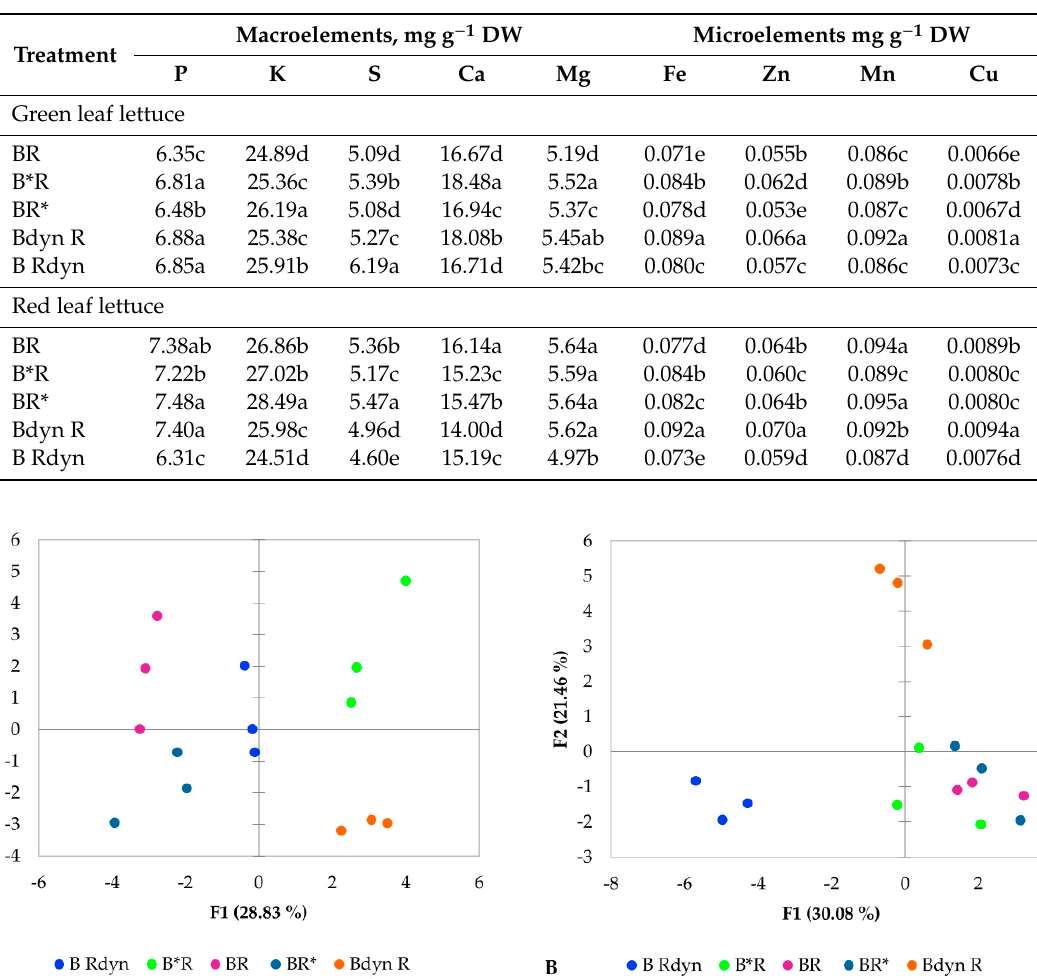
Table 4. The contents of micro-and macroelements in red and green lettuce leaves, illuminated with constant and dynamic intensities of red 662 nm and blue 452 nm light. Di ff erent letters indicate statistically significant di ff erences between means according to the Duncan’s multiple range test at the confidence level p = 0.05.